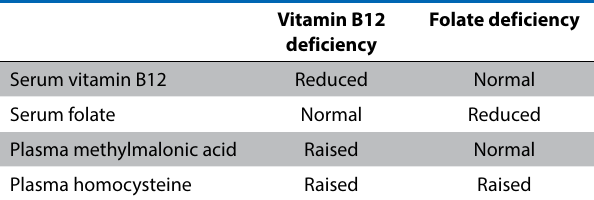
Table 3. Results of biochemical investigations in vitamin B12 vs folate